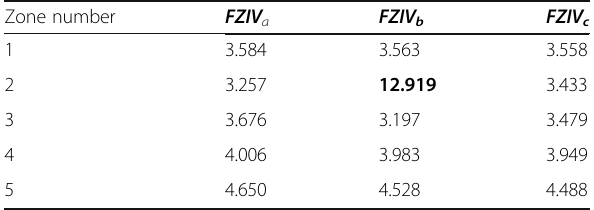
Table 2 FZIV for a BG fault occurring in protection zone 2